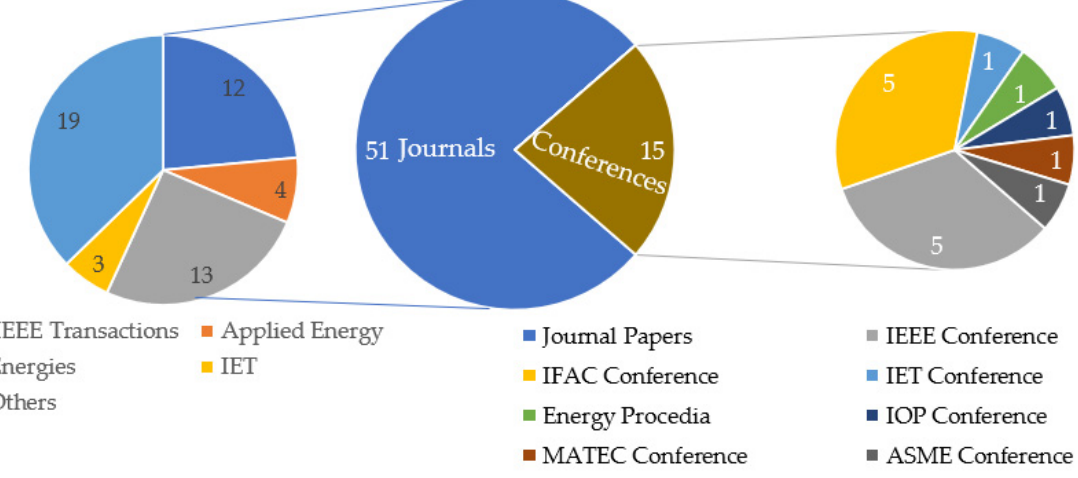
Figure 6. Journal and conference papers on MPC published on various platforms.